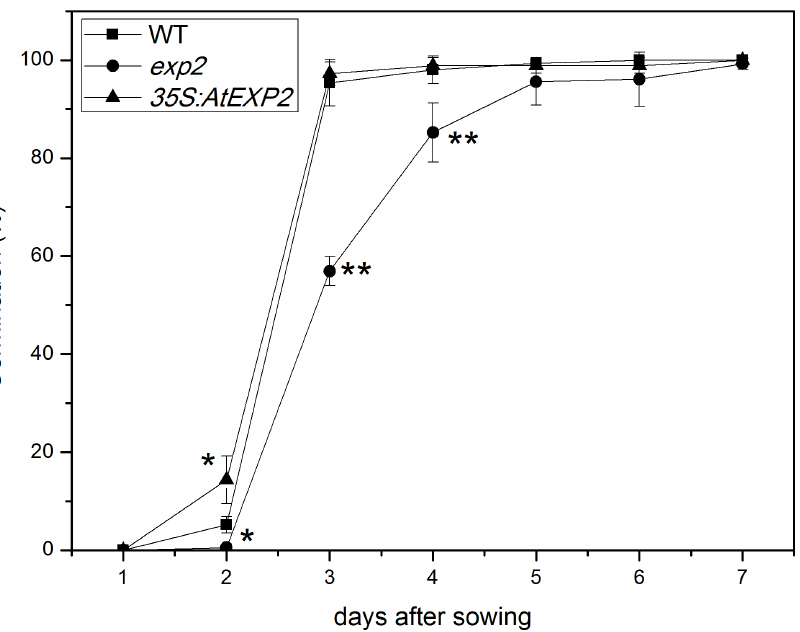
Figure 3. Germination phenotype of the wild type, exp2 and 35S:AtEXP2 line. Non-dormant seeds of wild type, exp2 and 35S:AtEXP2 overexpression line were employed in the germination assay. The germination frequencies were scored daily until the 7th day after sown. Error bars represent SD. A Student’s t-test was calculated at the probability of either 5% (*P , 0.05) or 1% (**P , 0.01).